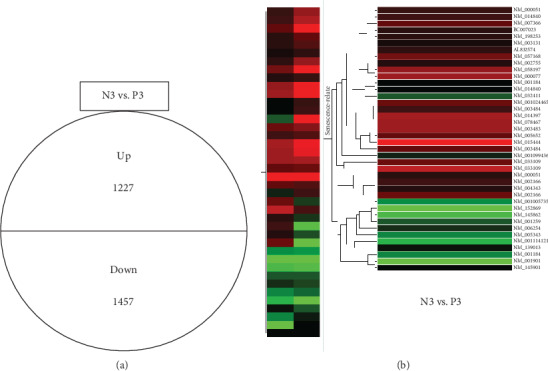
Comparison and cluster analysis of differentially expressed genes (DEGs) between N3 and P3. (a) Twofold upregulated genes and twofold downregulated genes were identified between N3 and P3. N3: hUCB-MSCs at passage 3, normal pregnancy; P3: hUCB-MSCs at passage 3, preeclampsia. (b) Dendrogram showing differential senescence-related gene expression in hUCB-MSCs from women with normal pregnancy or preeclampsia. Differentially expressed genes (DEGs) related to senescence were compared between N3 and P3 cells. N3: early hUCB-MSCs at passage 3, normal pregnancy; P3: early hUCB-MSCs at passage 3, preeclampsia.